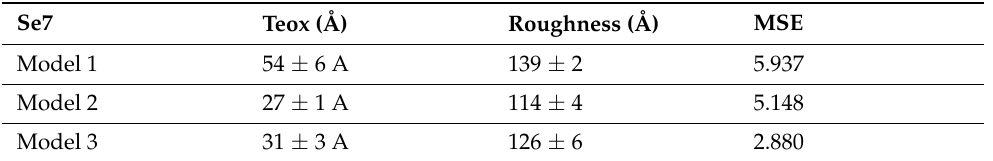
Table 2. Ellipsometry fit parameters obtained for the sample Se7 with the different models proposed in Figure